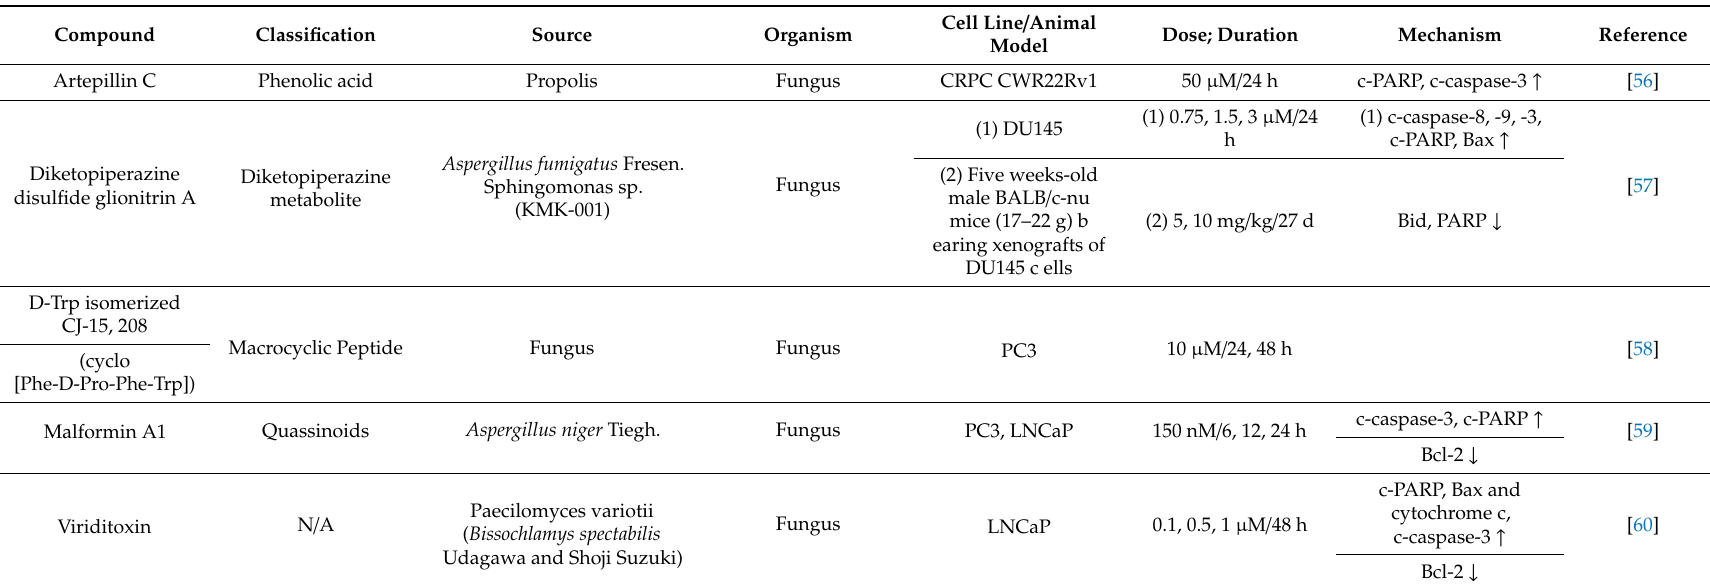
Table 2. Apoptosis inducing dietary compounds originated from